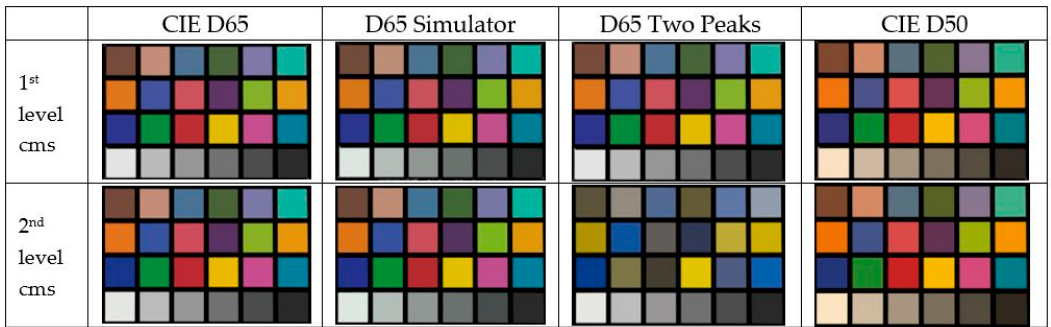
Figure 8. Screen capture of ColorChecker shown in the VR graphics engine with two levels of color management applied to four light sources: (first row) only applying changes in the color of the light sources and (second row) applying changes in the color of the light sources and recalculating the texture color of the VR object.